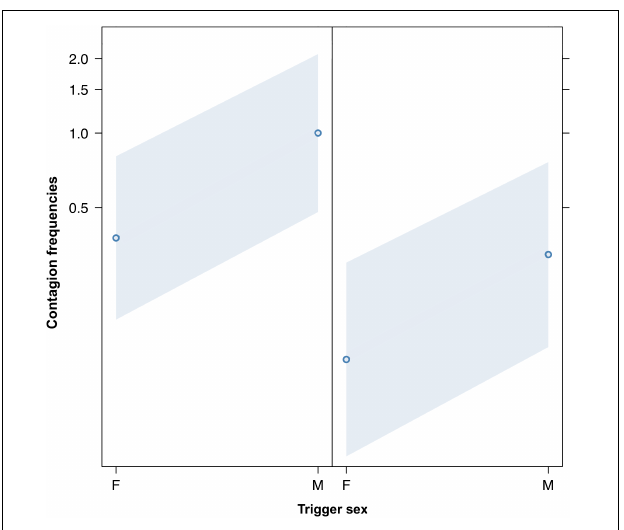
FIGURE 2 | Line plot of the effect of the sex of the trigger ( X -axis) on acoustic yawn contagion mean occurrence ( Y -axis). Effect of the trigger sex on acoustic yawn contagion when the responder is a female ( right ) and a male ( left ). Males’ yawns elicit more yawns than females’ ones regardless of the sex of the responder (result of the GLMM, p = 0.022). Points represent the effect that the response variable has on the independent variable “sex of the trigger,” based on the value predicted by the model. Colored bands show the 95% confidence interval. ( Table 1 ) even when the triggering stimuli are auditory